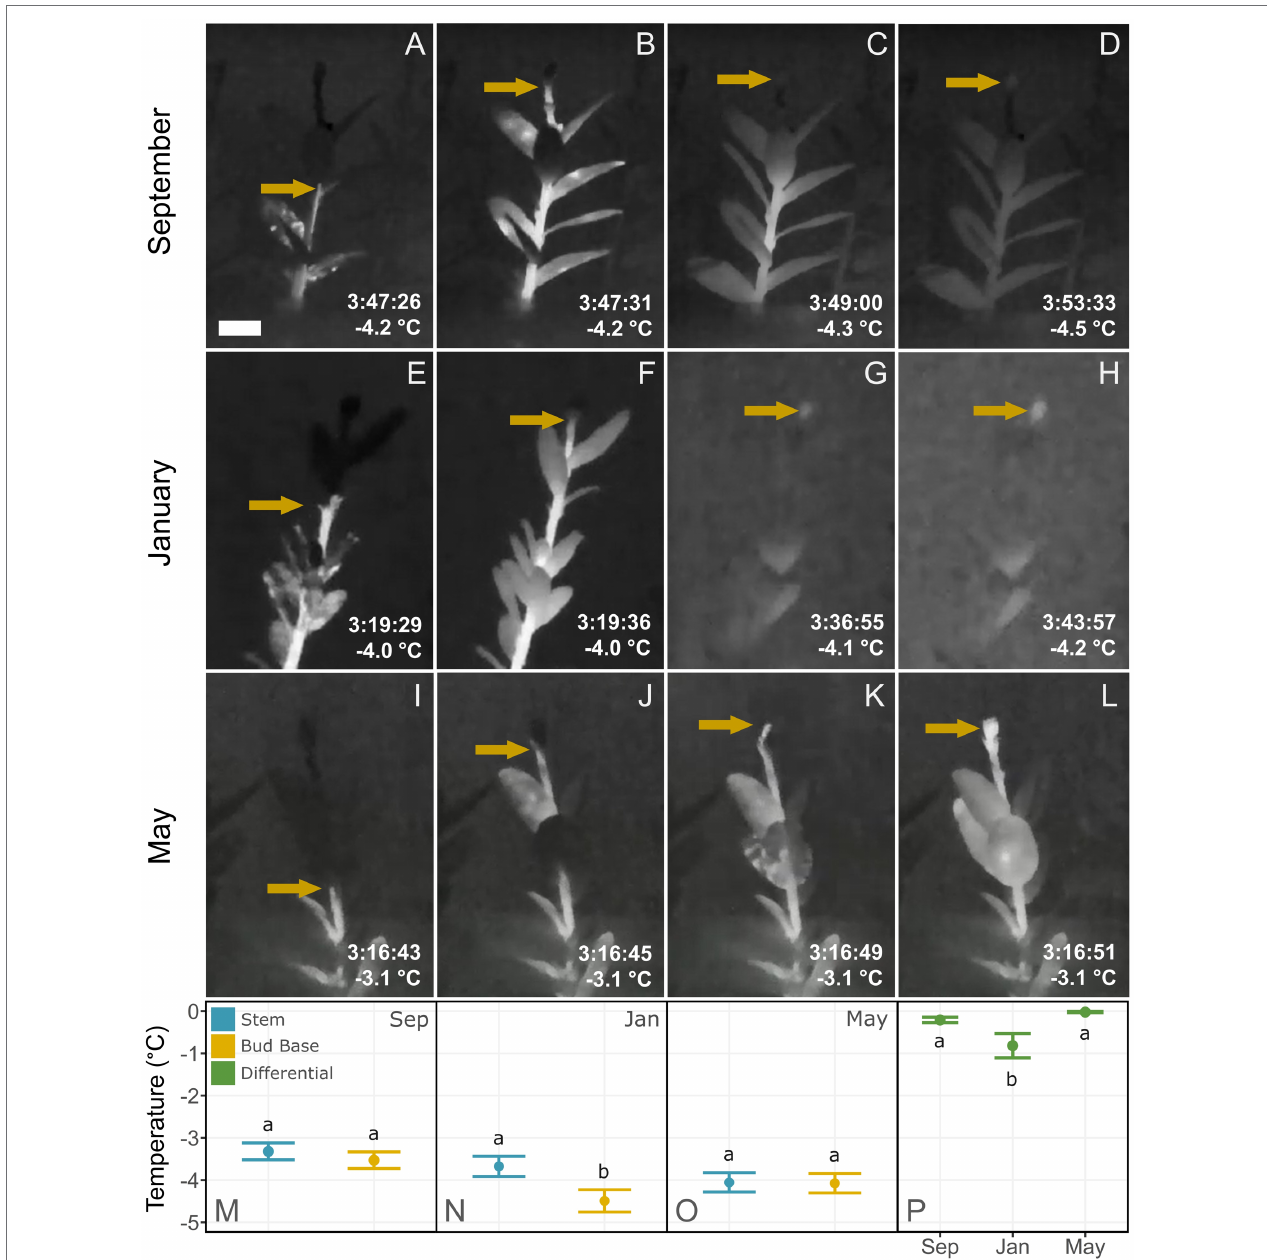
FIGURE 3 | Thermal recordings of freezing patterns in Vaccinium macrocarpon shoots. Plant material was sampled in September 2018 and January and May 2019 from a commercial farm in Nekoosa, WI. Time stamps represents the time elapse under the freezing treatment, only comparable under the same structure. Arrows highlight ice formation propagation. (A–D) Ice propagation in a shoot sampled in September 2018. (B,C) Arrow indicates ice propagation stops at the base of the bud. (D) Shortly after, bud freezing resumes, indicated by the arrow. (E–H) Ice propagation in a shoot sampled in January 2019. (F,G) Arrow indicates where ice propagation stops at the base of the bud. (H) Minutes later, bud freezing resumes, signified by the arrow. (I–L) Ice propagation in a shoot sampled in May 2019. (J,K) Arrows indicate where ice propagation progresses through the stem. (G,H) Ice propagation progresses uninterrupted into the bud. (M–O) Average temperature of initiation of freezing in the stem or bud for (M) September 2018, (N) January 2019, and (O) May 2019. (P) Differences between the freezing temperature of stem and bud at each sampling date. Lower case letters represent significant difference among the means in each plot. Scale bar = 5